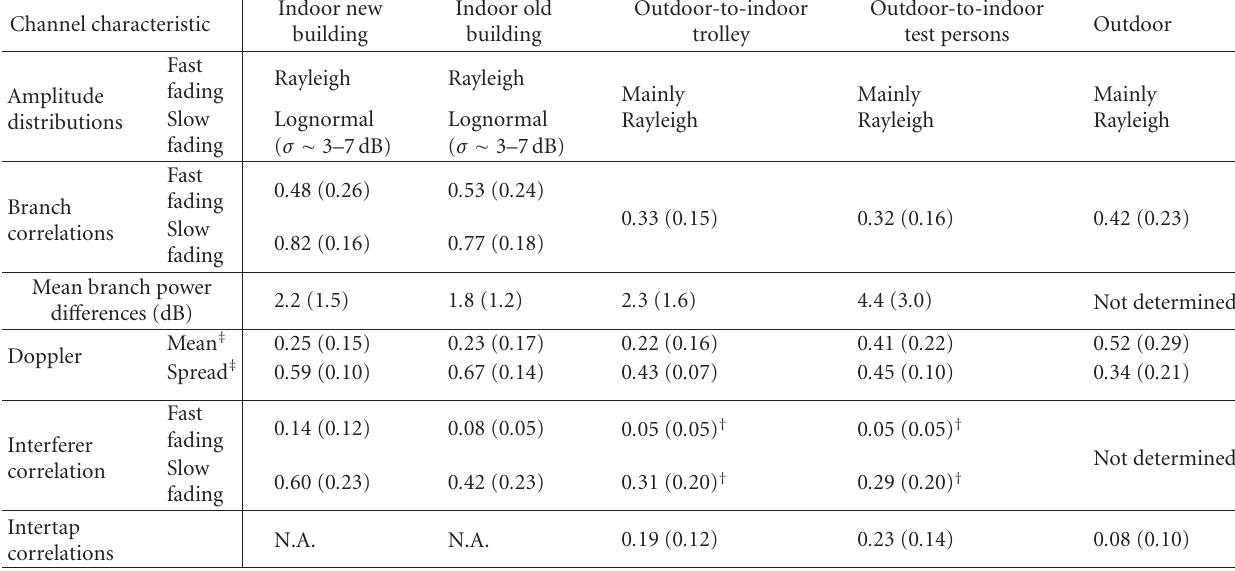
Table 2: Results of data processing for the di ff erent measurement campaigns. Given are the averages of the magnitudes of the considered variable, with standard deviations of the magnitudes in